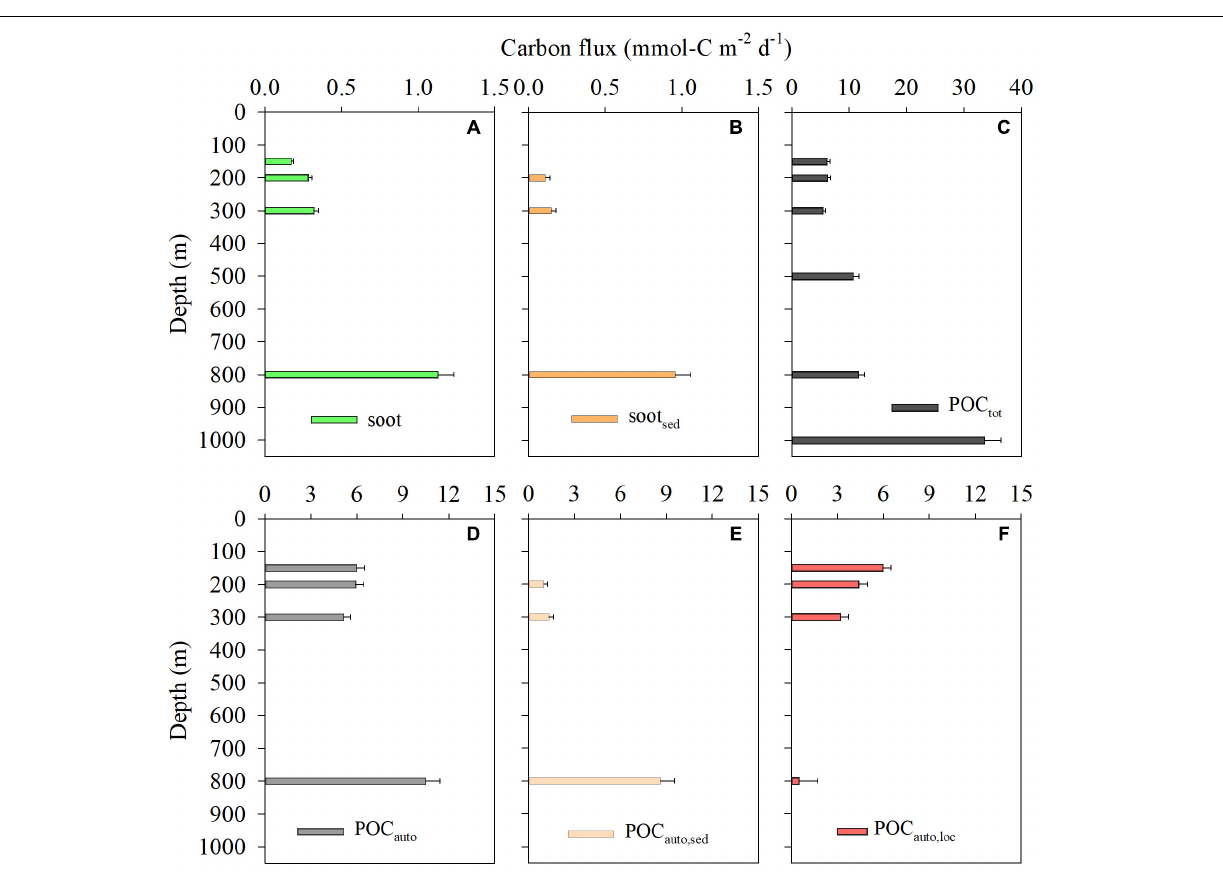
FIGURE 3 | Variations of POC and soot fluxes contributed by POC and soot from various pathways: (A) 210 Po-derived total soot fluxes, (B) sediment-contributed soot fluxes